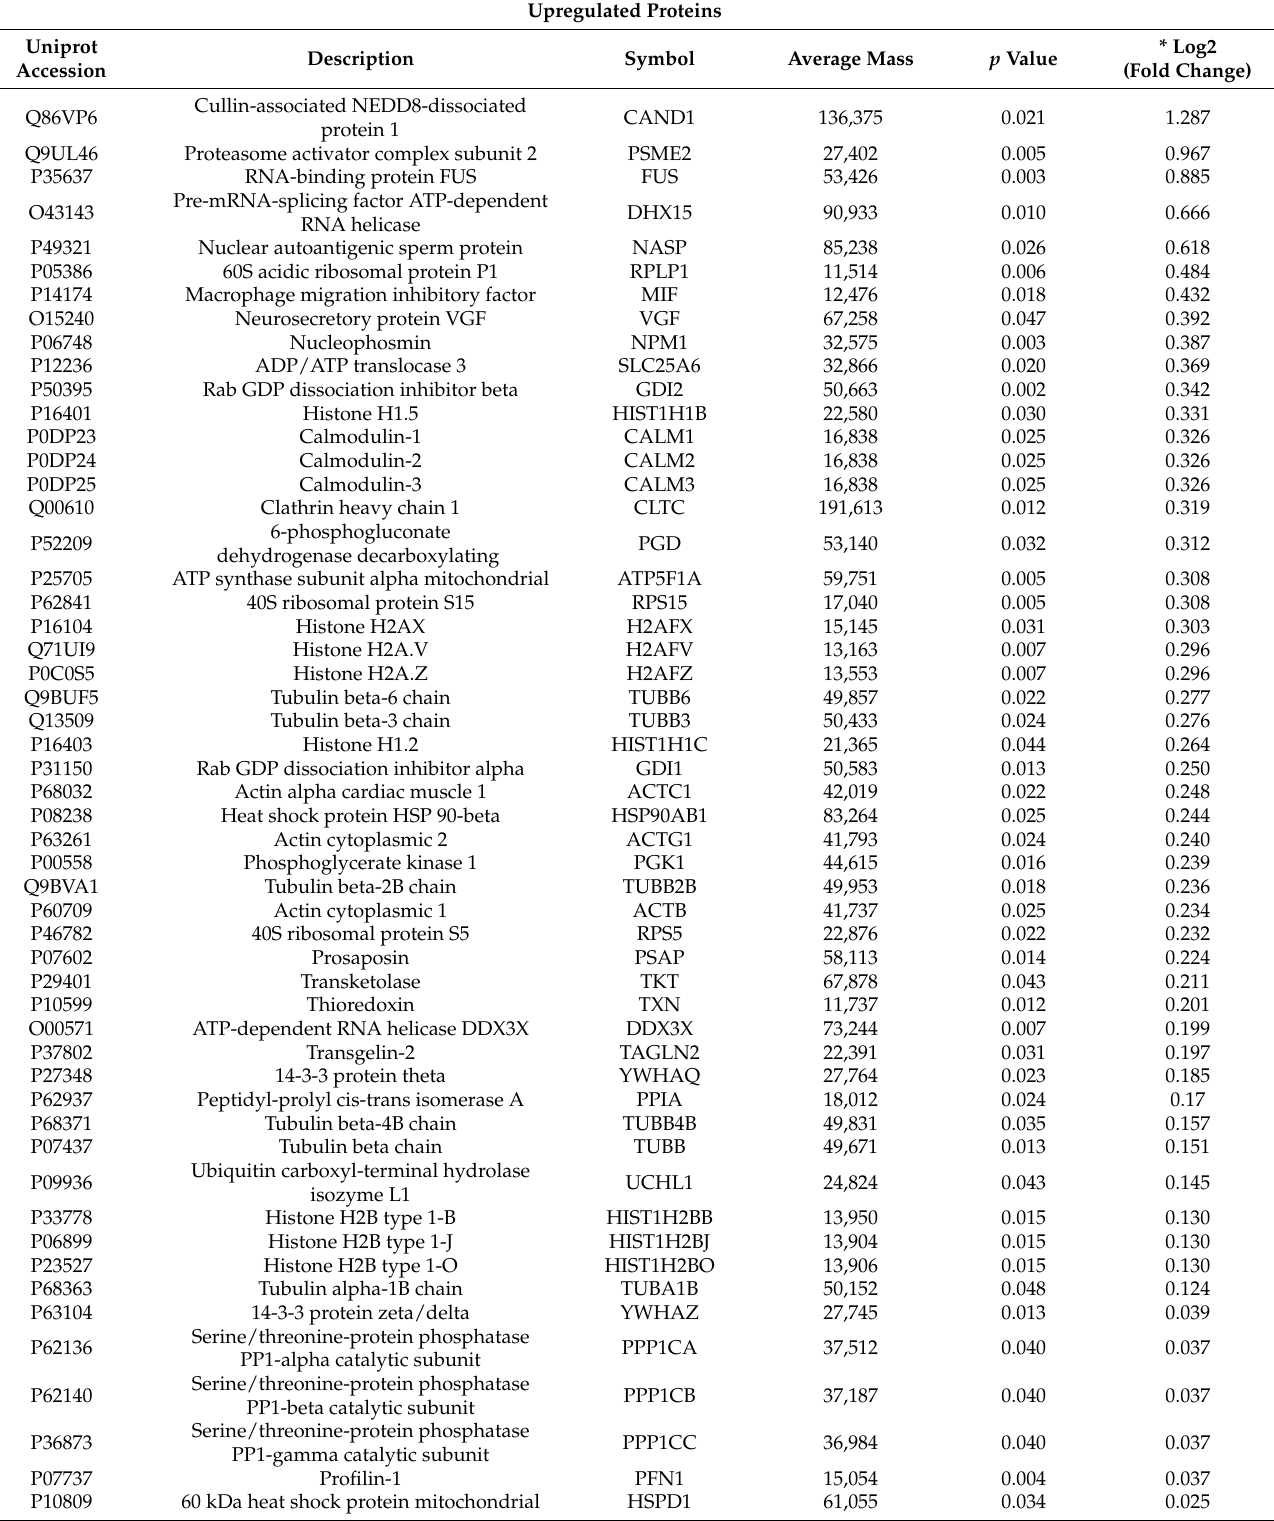
Table 1. Differentially expressed total protein extract from TRF-treated diff-neural cells compared to untreated